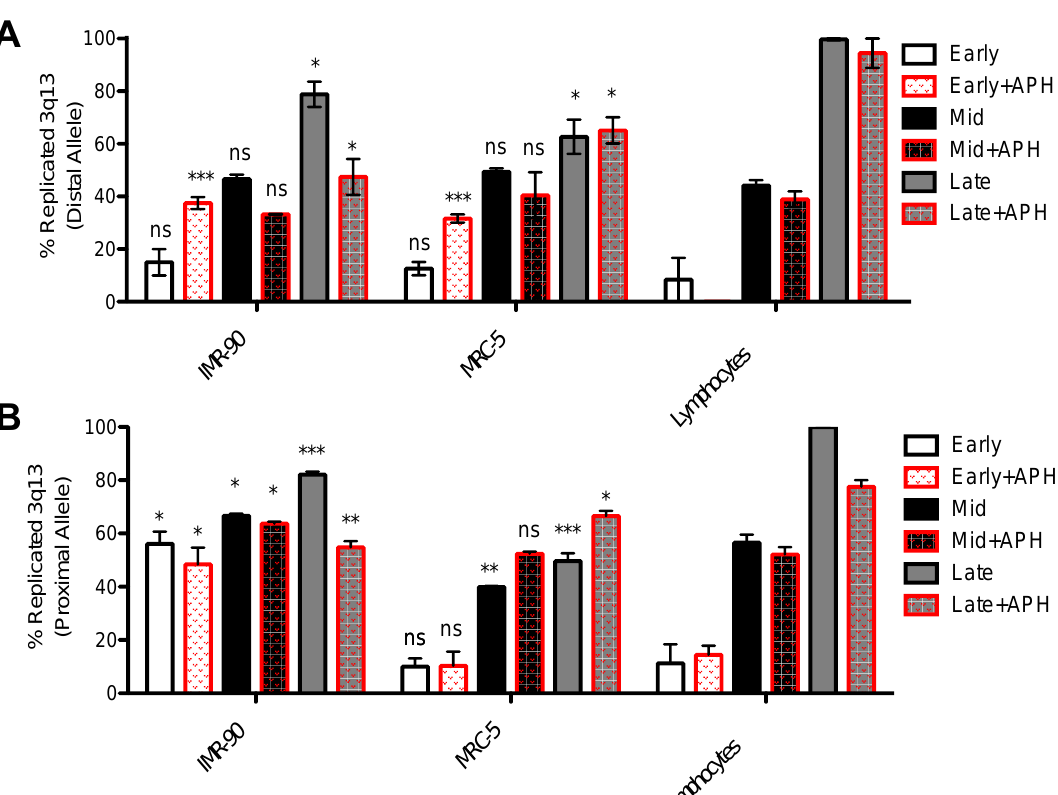
Figure 6. Replication timing analysis of 3q13.3 fragile region on both fibroblast cell lines. The histograms show the replication timing in MRC-5 and IMR-90 cell lines in normal and stressful conditions. The replication timing of lymphocytes was used as control for both fibroblast cell lines. Percentage of replicated distal ( A ) and proximal ( B ) probes are shown. The mean of three individual experiments is plotted, with error bars representing the SEM. p -values were calculated on the basis of differences between each condition in fibroblasts with the corresponding treatment in lymphocytes. ns: non-significant; * for p ≤ 0.05, ** for p ≤ 0.01, and *** for p ≤